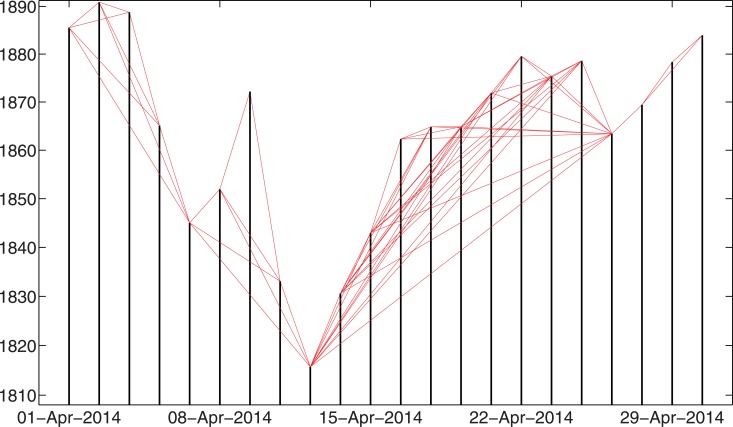
Example of the constructed networks by the absolute invisibility algorithm.This example is based on the S&P 500 Index daily close price in April, 2014. Note that the non-trading dates have been removed from the figure.